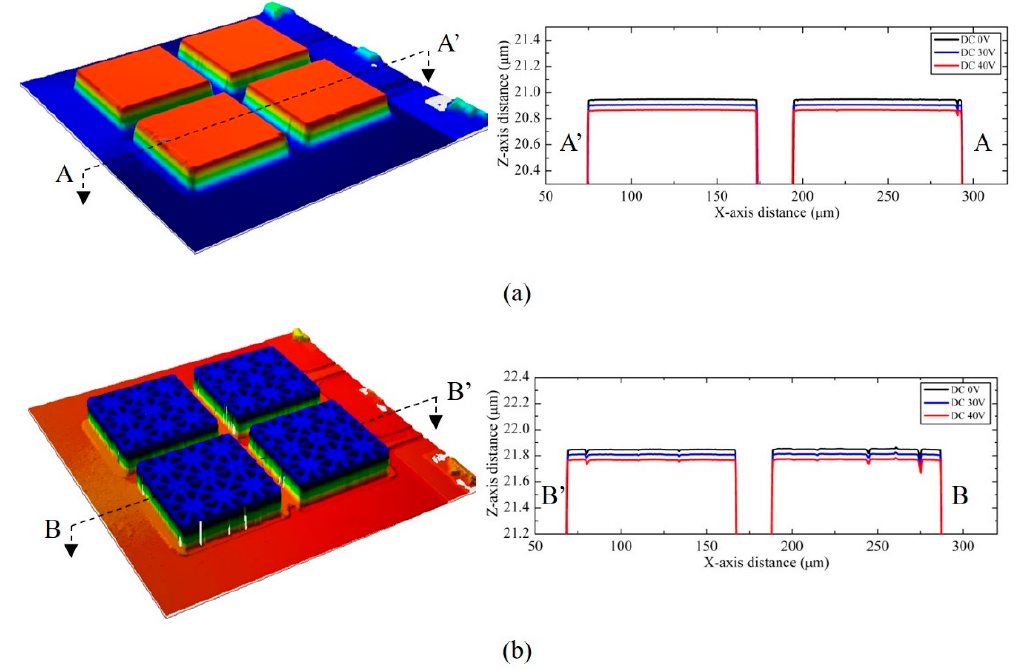
Figure 6. ( a ) A 3D surface profile of the plane 2D CMUT element at 0 V DC bias, and its corresponding 2D profile plot along the line A − A’ at different DC biases, 0 V (black), 30 V (blue), and 40 V (red), respectively. ( b ) A 3D surface profile of the truss 2D CMUT element at 0 V DC bias, and its corresponding 2D profile plot along the line B − B’ at different DC biases, 0 V (black), 30V (blue), and 40V (red), respectively.